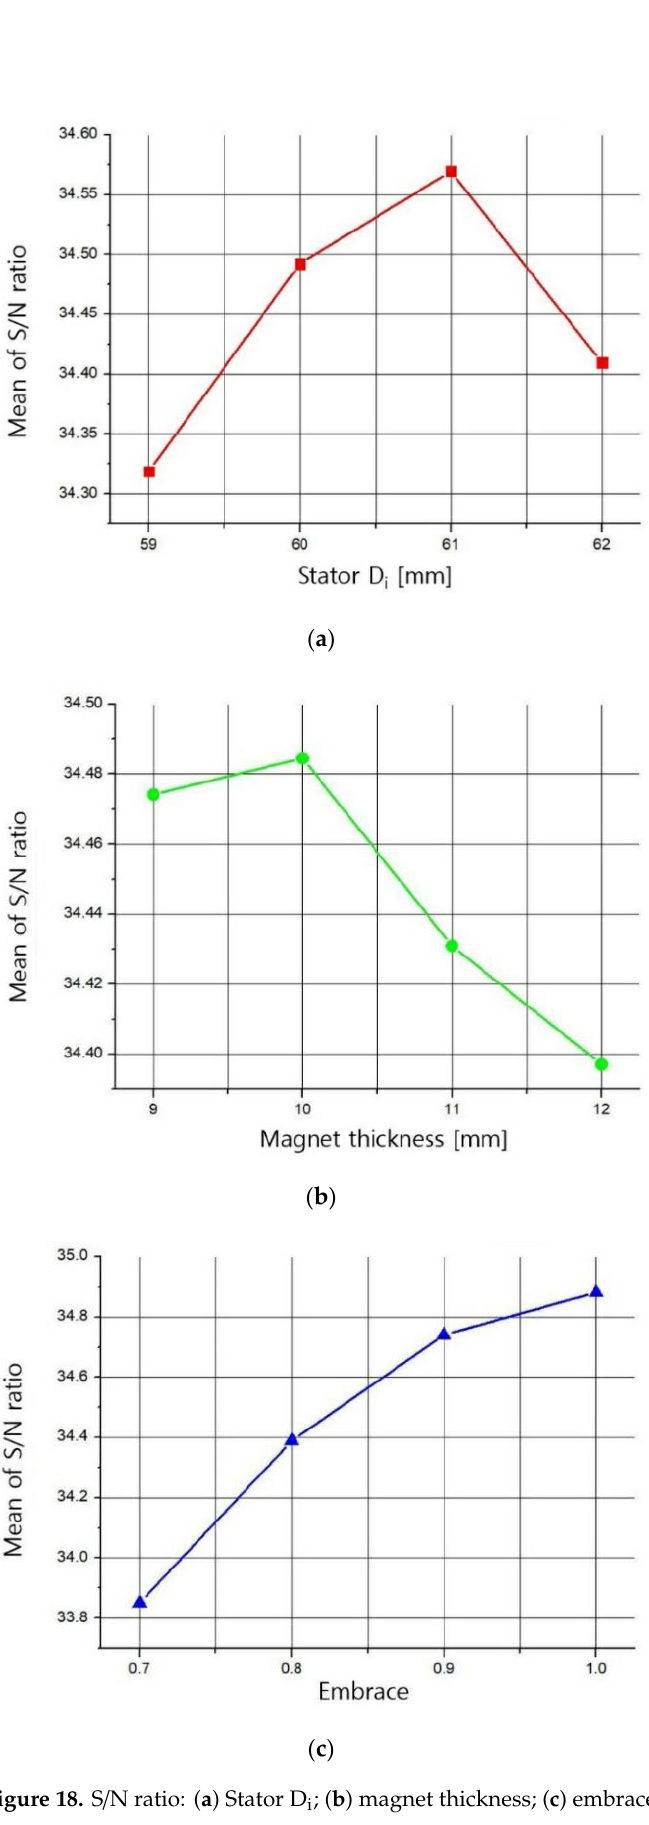
Figure 18. S/N ratio: ( a ) Stator D i ; ( b ) magnet thickness; ( c ) embrace. Figure 18. S / N ratio: ( a ) Stator D i ; ( b ) magnet thickness; ( c )